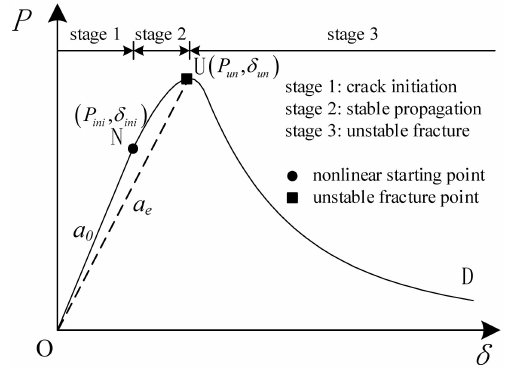
Figure 2. P– δ curve of a three-point bending beam